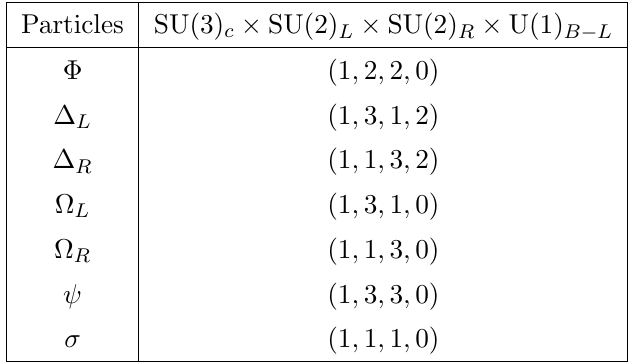
Table 1 . Fermion content of the model.